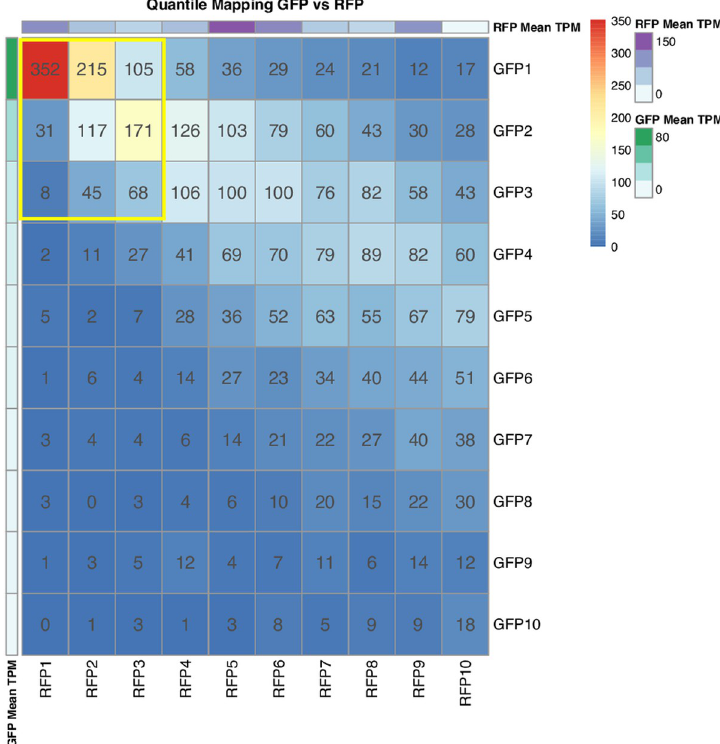
Fig 4. Quantile mapping of GFP+ thrombocyte and RFP+ thrombocyte datasets. We have divided the expressed genes in each dataset into 10 quantiles. We have compared the genes in each quantile across the pair of datasets. In each quantile, the quantile map shows the number of common genes between the two datasets. The bars on the right of the quantile map indicate the color codes and the number of genes. The data value bars on the rightmost indicate mean TPM values; green color, the highest TPM values for GFP+ thrombocytes, and purple color, the highest TPM values for RFP+ thrombocytes.